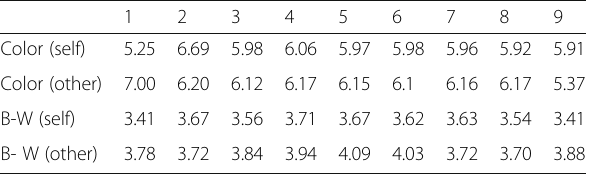
Table 1 Contrast between the entropy of looking at yourself and looking at others